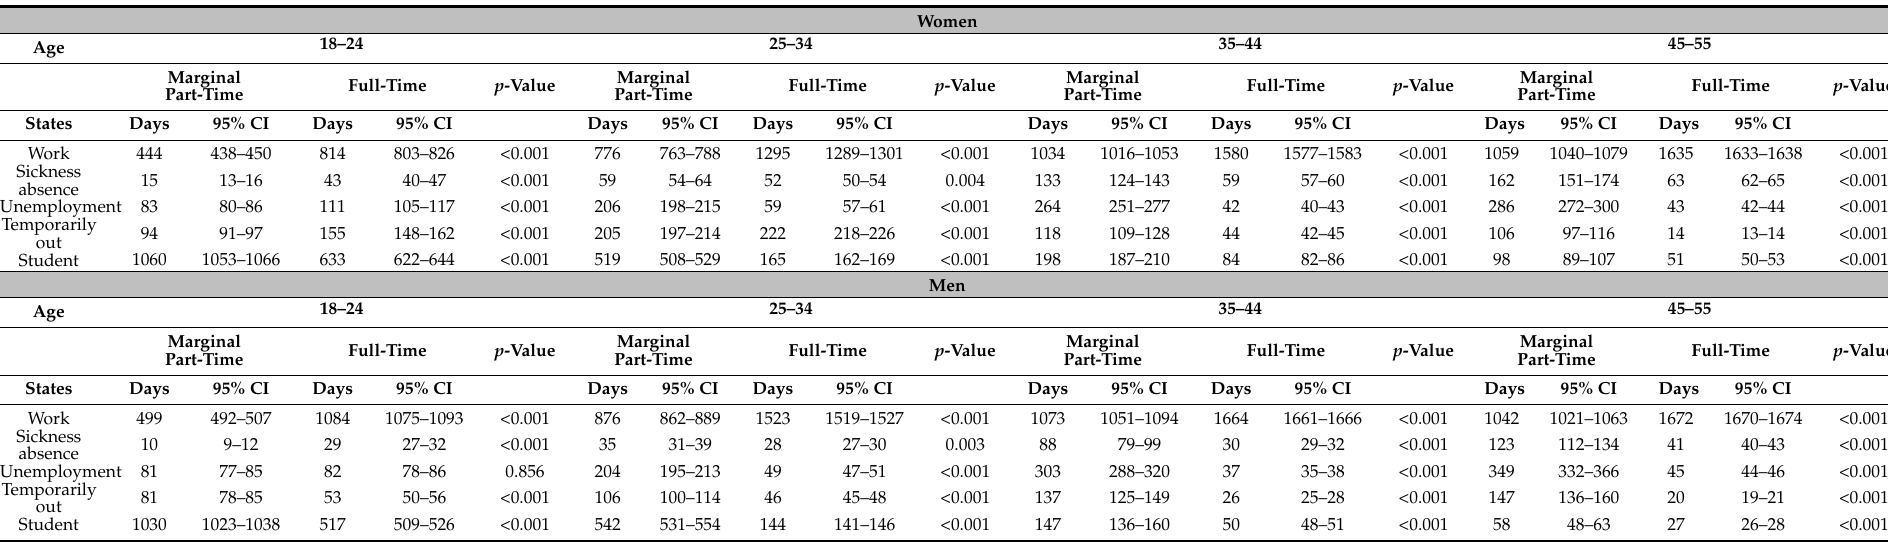
Table 2. Numbers of days in different labor market states during the five years of follow-up by gender and age